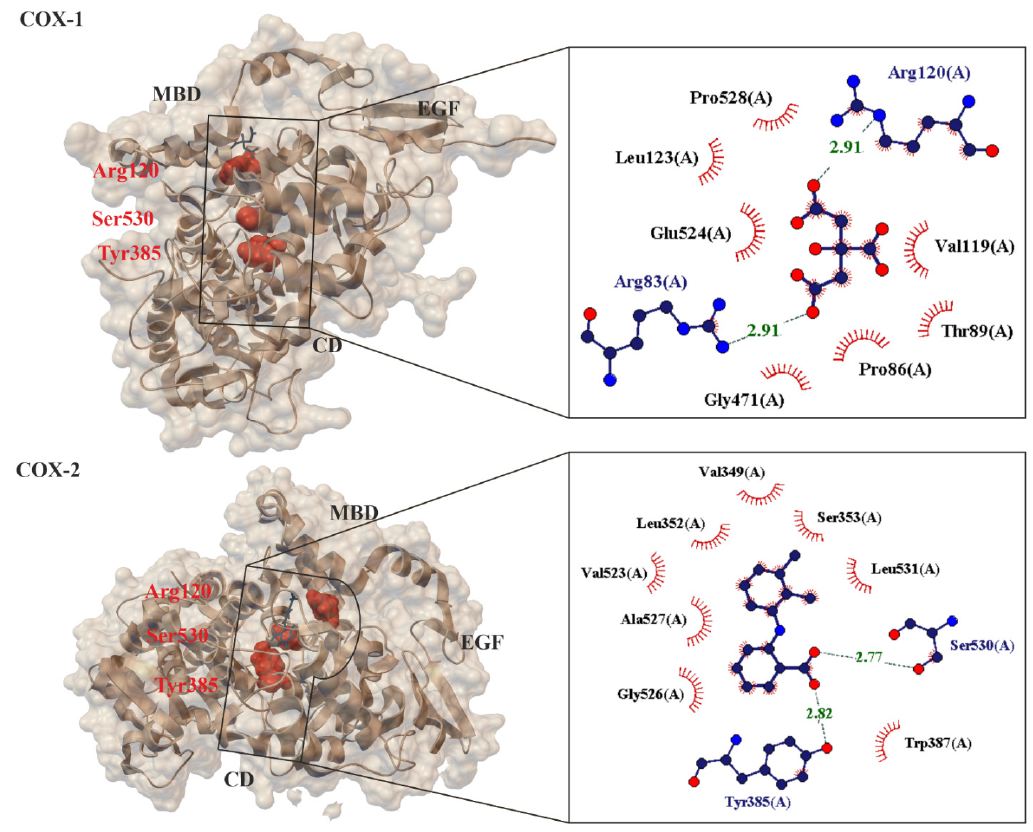
Figure 3. Comparison of 3-D crystal structures of human cyclooxygenase COX-1 (PDB 6y3c, 3.36